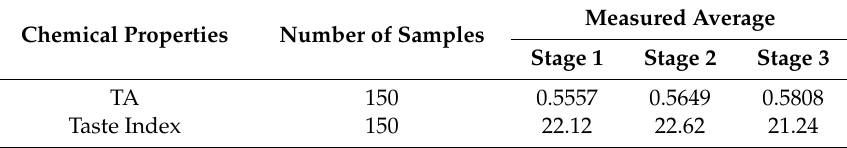
Table 2. Measured average of chemical properties in three stages of harvest.